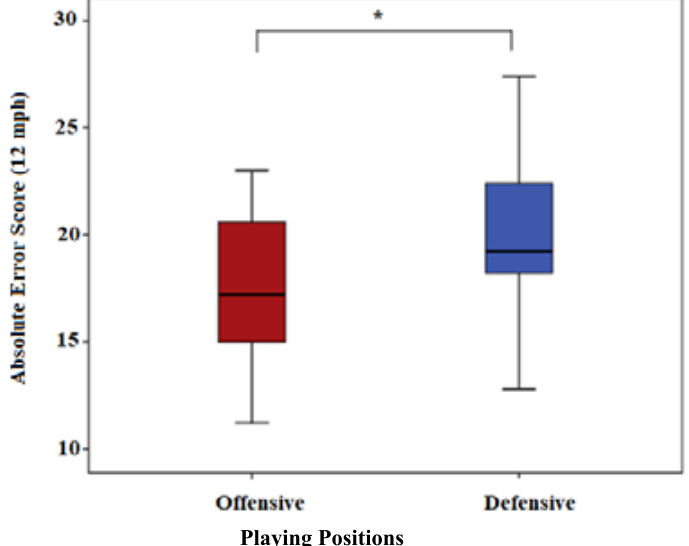
Figure 3. Comparison of Absolute Error Scores (12 mph) of players according to playing